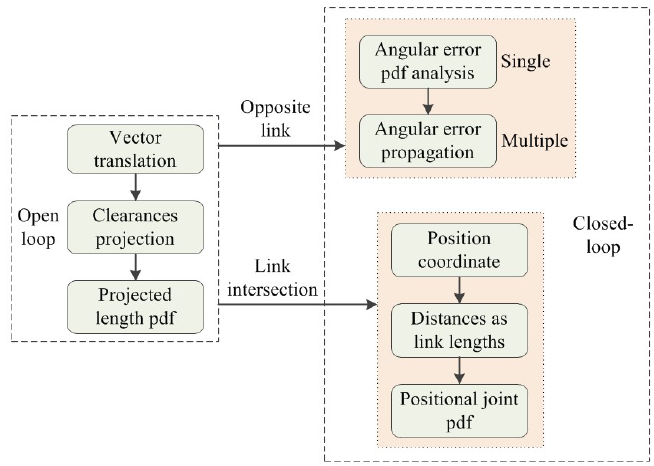
Figure 14. The calculation